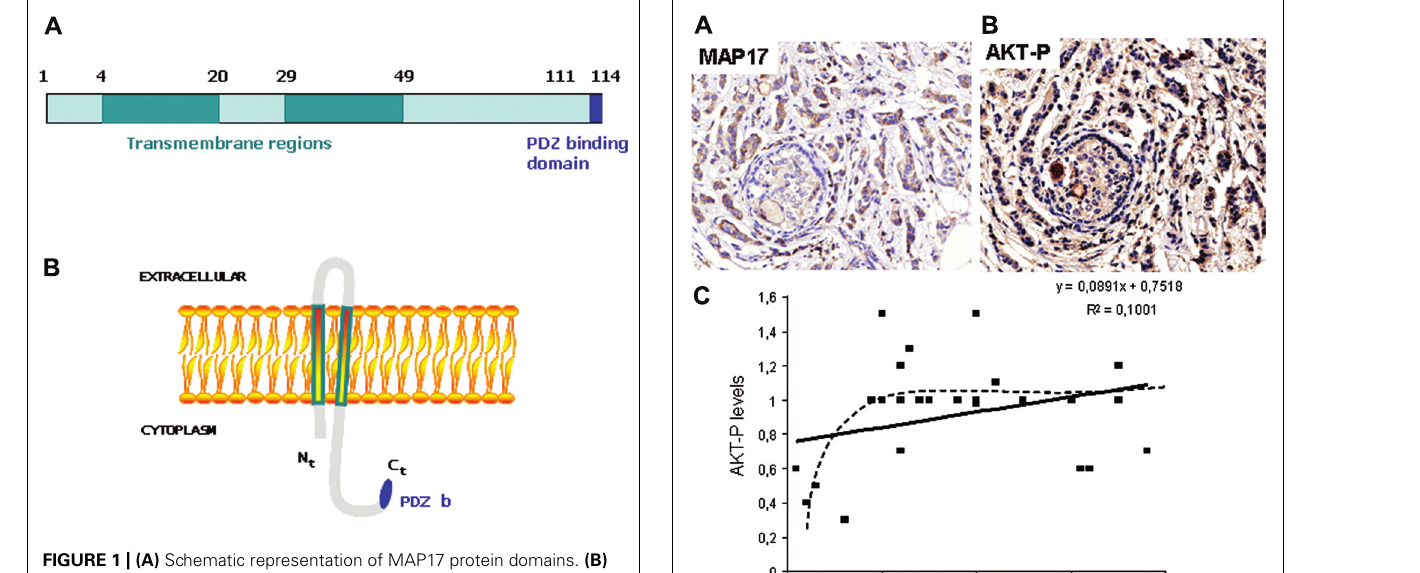
FIGURE 2 | (A) Representative picture of human breast tumors overexpressing MAP17. (B) Same tumor sample showing activated AKT (phosphorylated at S473). (C) Correlation between MAP17 expression and AKT activation in breast tumor samples